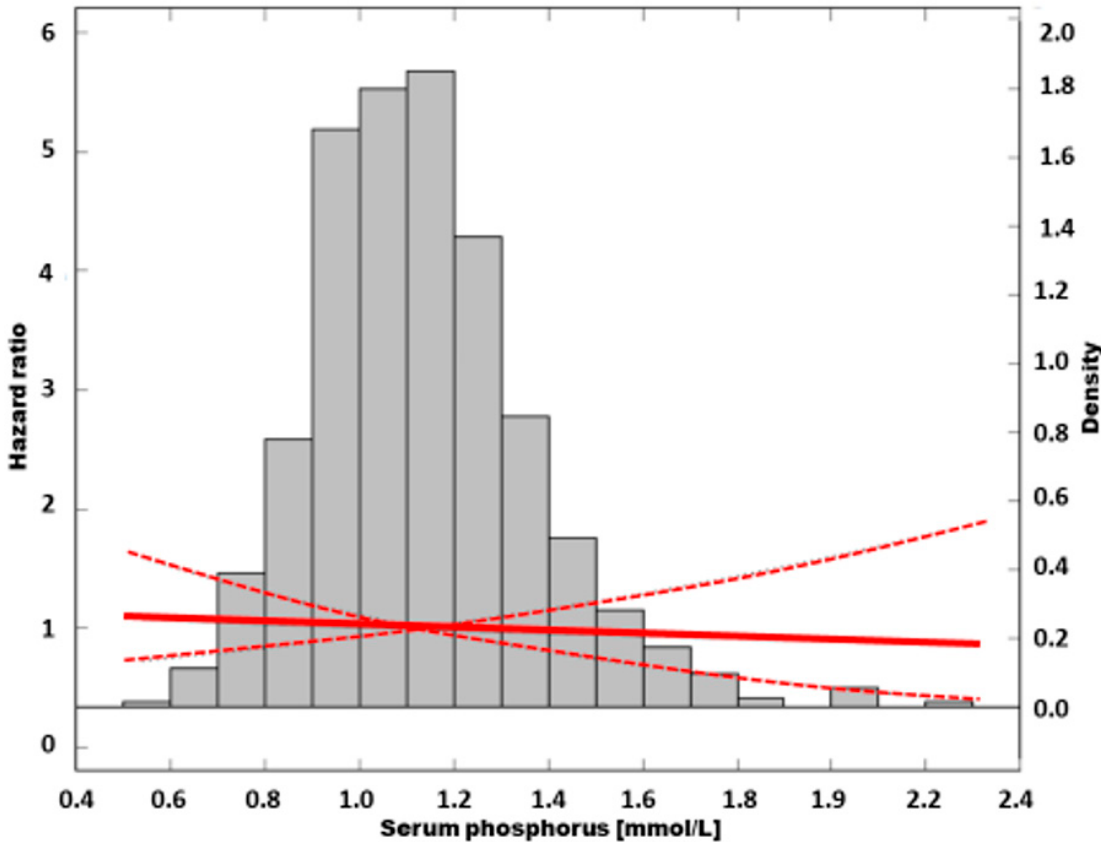
Figure 5. The association of all-cause mortality risk and serum phosphorus in fully adjusted model. Our final analysis was designed to identify the risk attributable to sP taken as a continuous variable together with all potential confounders, such as age, sex, BMI, weight loss, hsCRP, eGFR MDRD , serum calcium, LVEF, serum sodium, NTproBNP, the use of beta- blockers and digoxin, loop diuretic dose, and the percentage of the recommended dose of ACEI/ARB and aldosterone antagonist administered to patients. In this final model, the only significant independent predictors of mortality were NYHA class (HR =